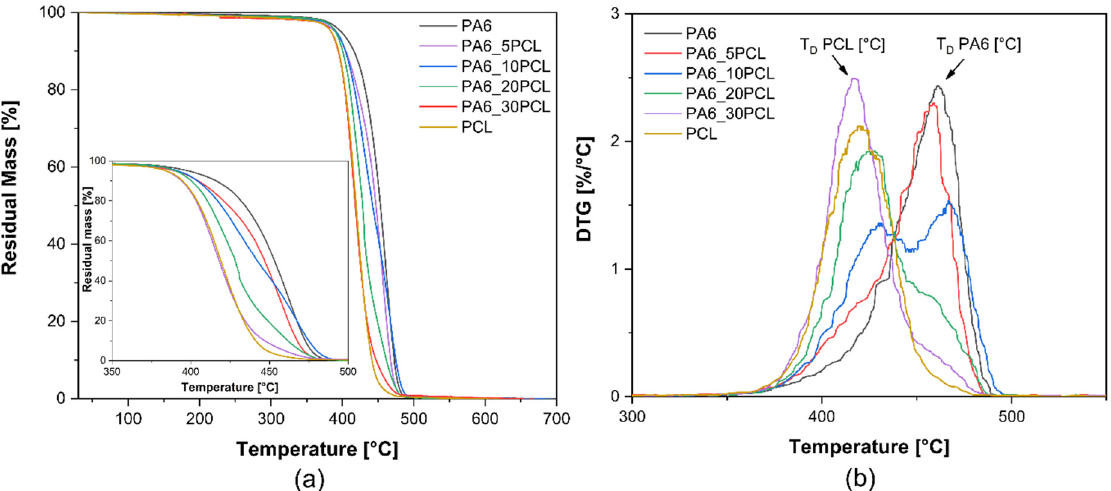
Figure 8. TGA tests on the prepared PA6/PCL blends. ( a ) Residual mass and ( b ) mass loss derivative curves. Table 2. Results of the TGA analysis performed on the prepared PA6/PCL blends. Sample